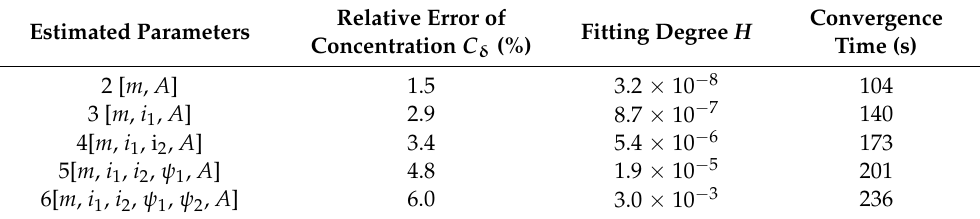
Table 2. Comparison results under a different number of estimated parameters.